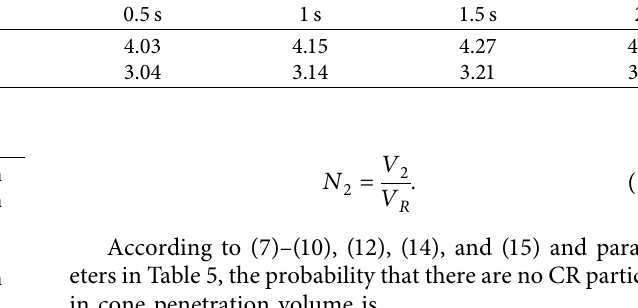
Figure 10: Needle penetration process. (a) Needle penetration process. (b) Cone penetration process. Table 4: Final penetration depth of needle/cone contacting CR particles at different moments.